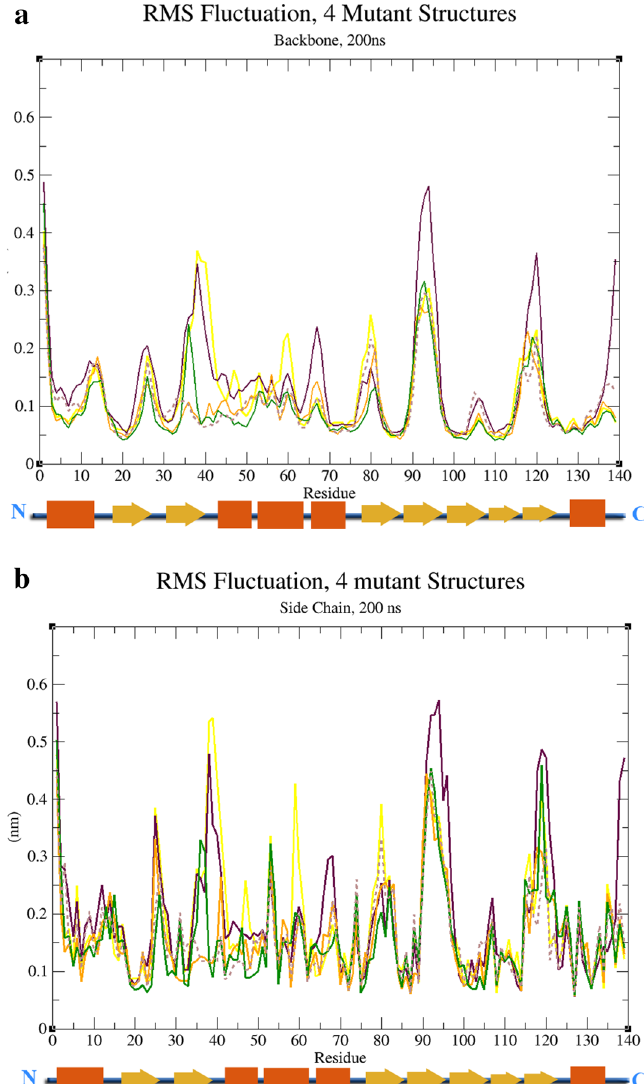
Figure 7. Root Mean Square Fluctuations (RMSF) of backbone and side-chain atoms versus residue number of the WT, and all mutant structures. ( A ) RMSF structures based on the backbone fluctuations of all structures. ( B ) RMSF structures are based on side-chain fluctuations of all